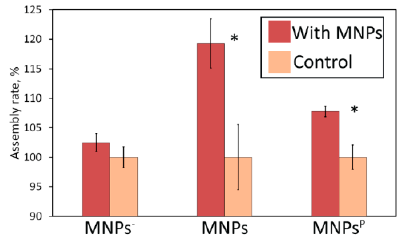
Figure 6. HR in the presence of MNPs, MNPs - , and MNPs P immediately after mixing siRNA with NPs. * p < 0.05.